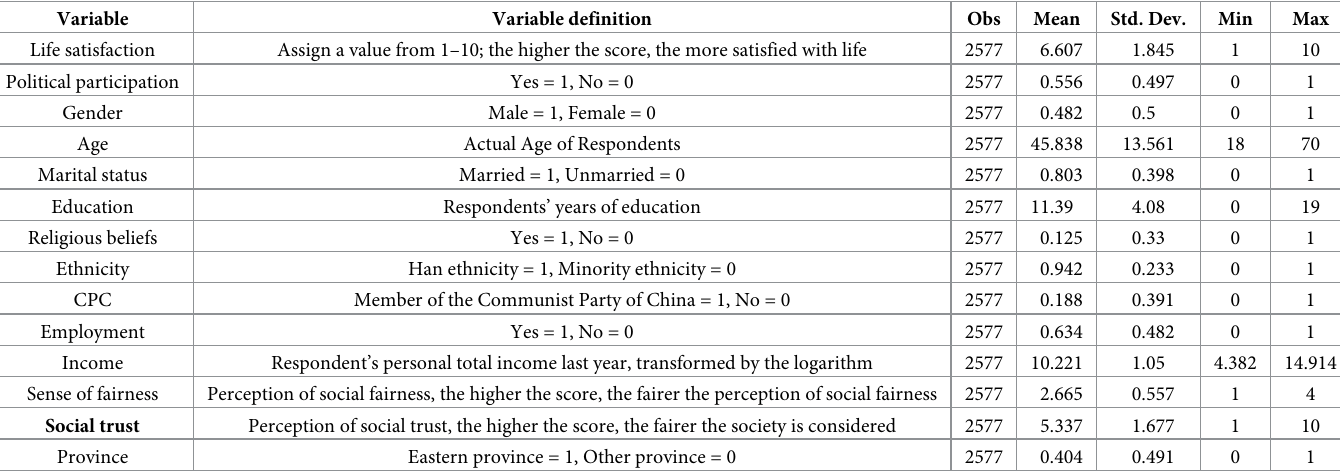
Table 1. Variable definition and descriptive